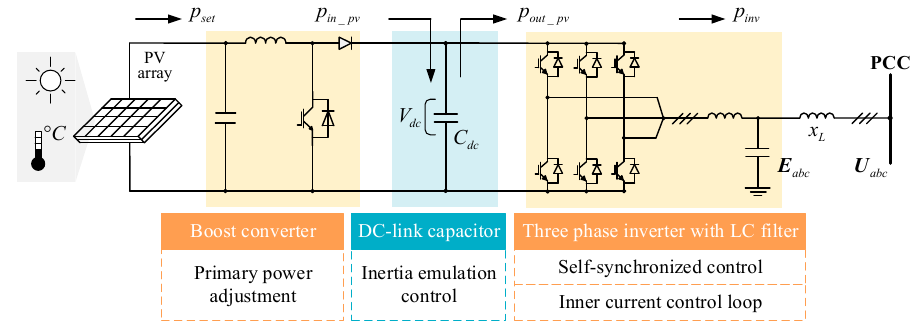
Figure 4. System configuration and control structure of a two-stage photovoltaic (PV) system with a virtual inertia frequency control (VIFC) strategy.